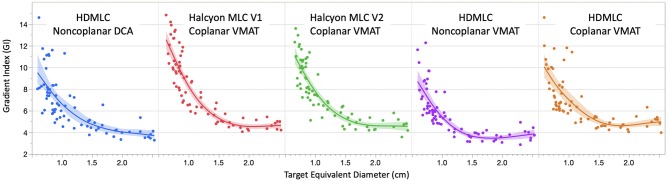
Comparison of gradient index (GI) variation as a function of target equivalent diameters for five planning and delivery techniques. Dots are the actual GI for an individual target. Solid lines are fitting lines using spline model and shaded areas are 95% confidence interval of fit. Only GIs < 15 are included in the graph to avoid data skewing due to bridging 50% isodose lines.